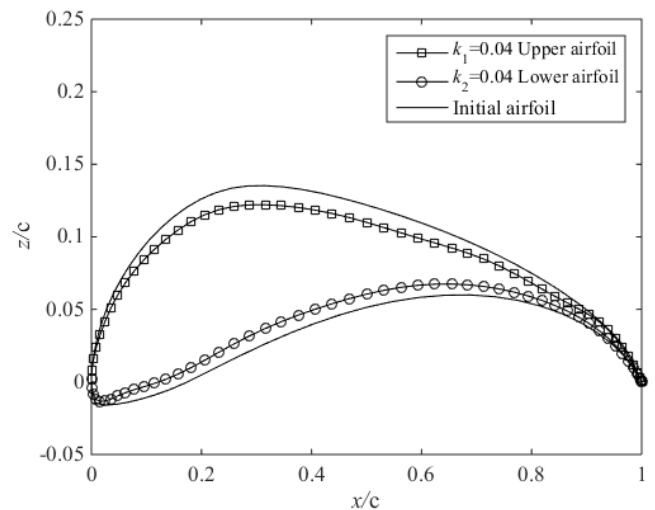
Figure 16. Range of the S1223 airfoil at k 1upper = 0.04 and k 2lower = 0.04.